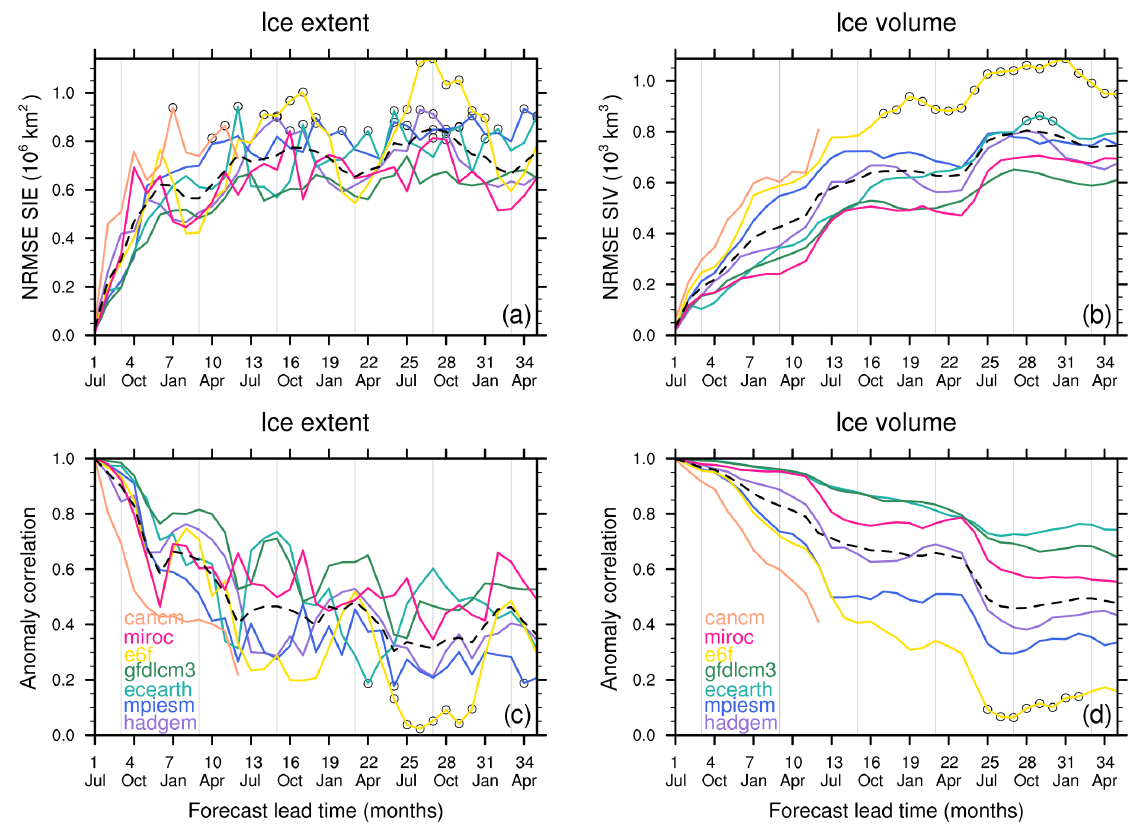
Figure 5. (a, b) Lead-time dependence of SIE NRMSE and SIV NRMSE for all models. (c, d) Lead-time dependence of SIE ACC and SIV ACC for all models. September and March are marked by thin grey vertical lines. Dashed lines represent the averages across models. Circles indicate where metrics do not indicate significant predictability (at 95%). Updated from Tietsche et al.